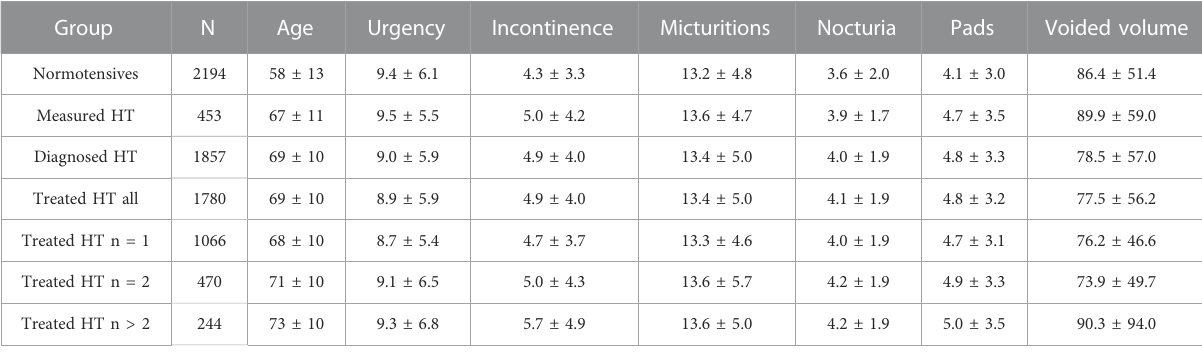
TABLE 1 Baseline parameters in normotensive and hypertensive patients.